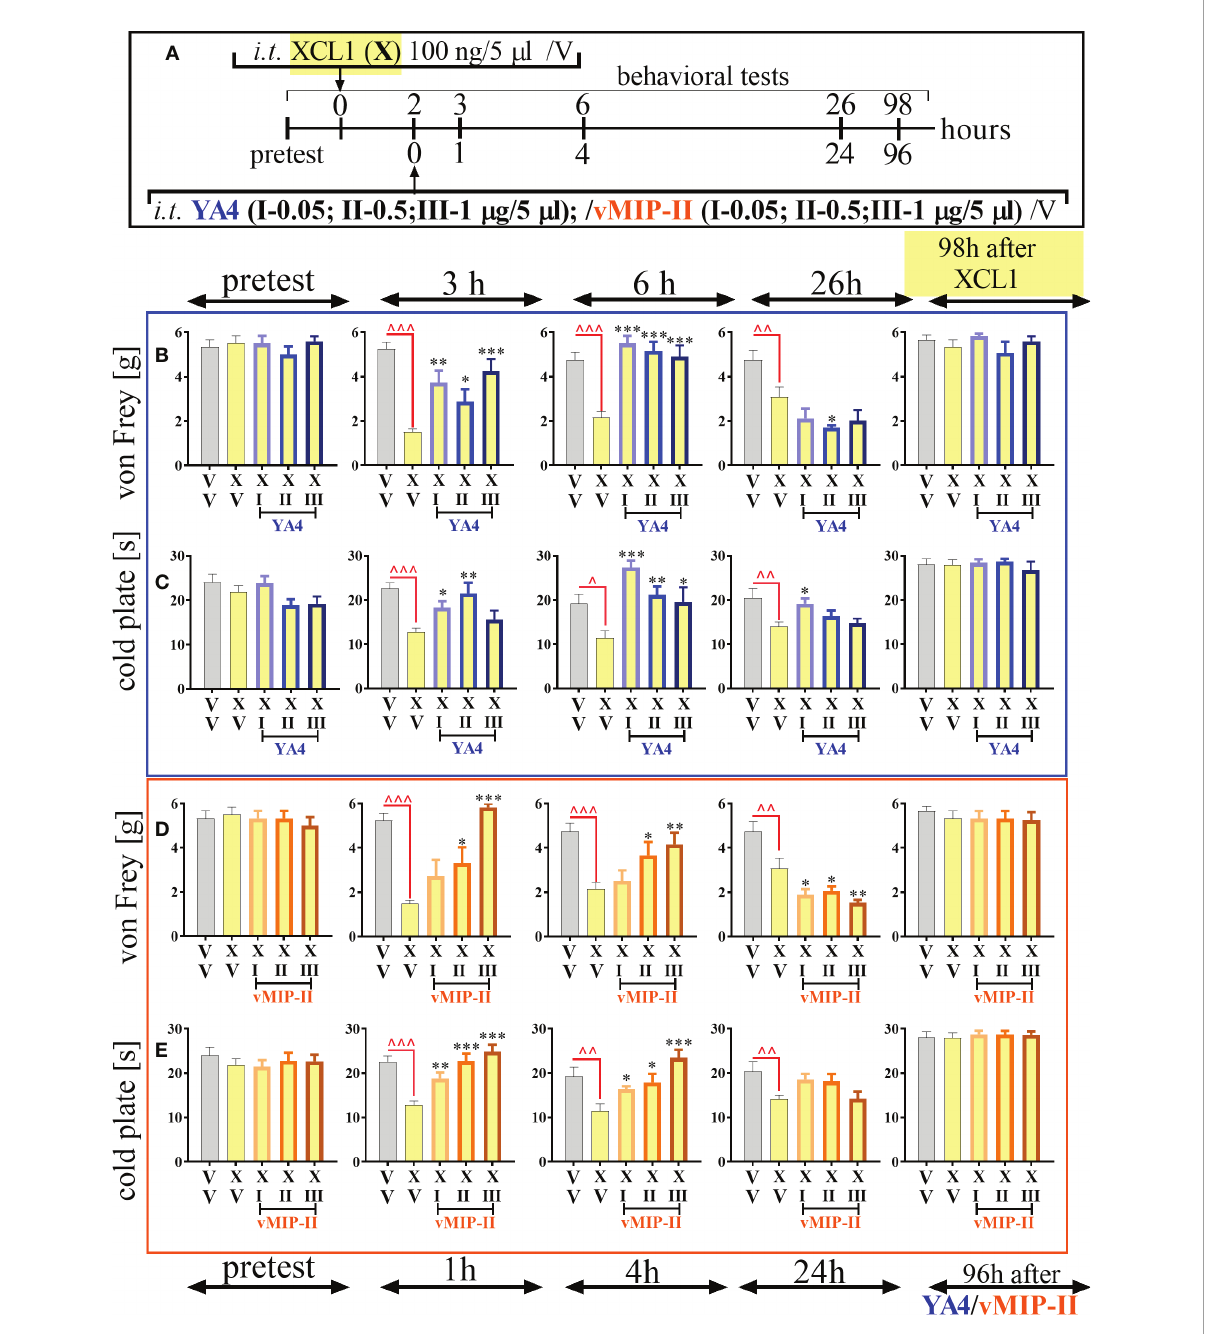
FIGURE 5 The in fl uence of ITGA9 neutralization by YA4 (B, C) or XCR1 blockade by vMIP-II (D, E) , according to scheme (A) , at a dose of 0.05 (I), 0.5 (II), 1 (III) m g/5 m l on mechanical (B, D) and thermal (C, E) hypersensitivity in naive mice after pronociceptive XCL1 100 ng/5 m l (X) administration. Data are presented as the mean ± SEM (n =4 – 6). The results were evaluated using one-way ANOVA followed by Bonferroni ’ s post hoc test for comparisons of selected pairs; ^p <0.05; ^^p< 0.01; ^^^p <0.001 indicate signi fi cant differences between the veh-(V+V) vs. XCL1(X+V) – treated group; ✽ p <0.05; ✽✽ p< 0.01; ✽✽✽ p< 0.001 indicate signi fi cant differences between the XCL1(X+V) – vs. XCL1+YA4 – / XCL1+vMIP-II – treated groups. Abbreviations: “ V ”– vehicle